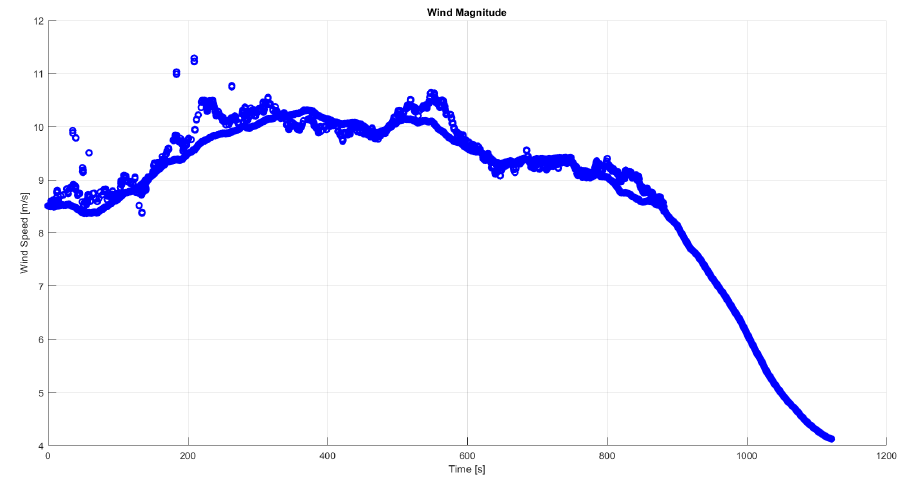
Figure 6. Wind recorded magnitude during the TAS − I drop test.